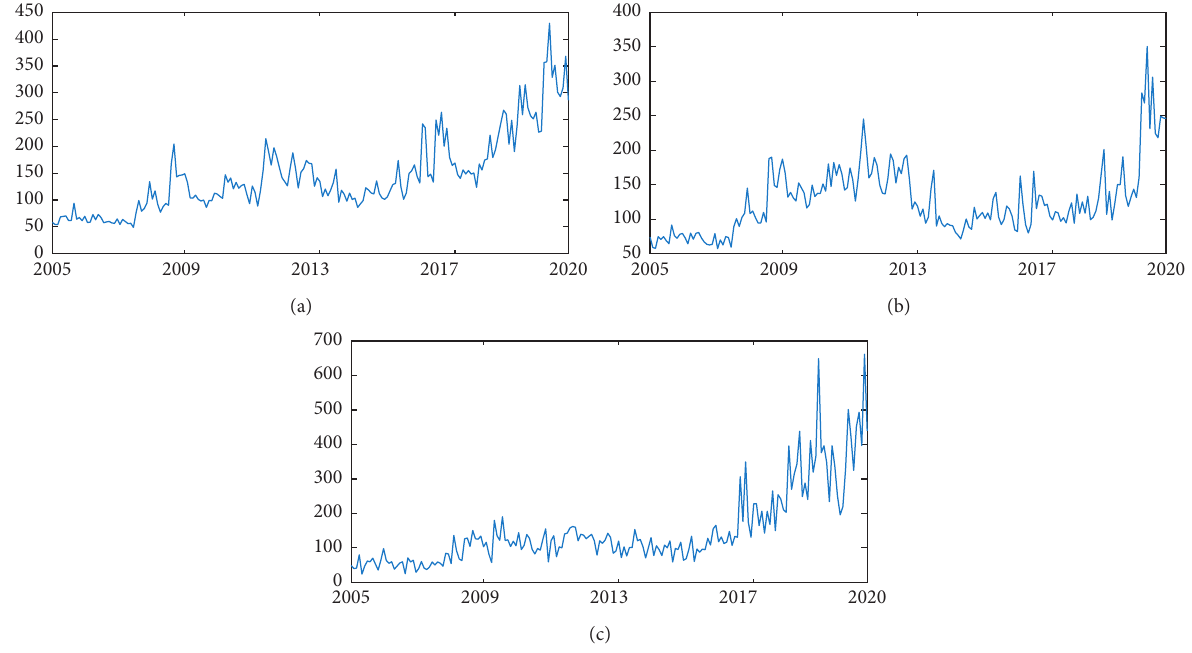
1, t . (b) S&P 500 return: r 2, t .